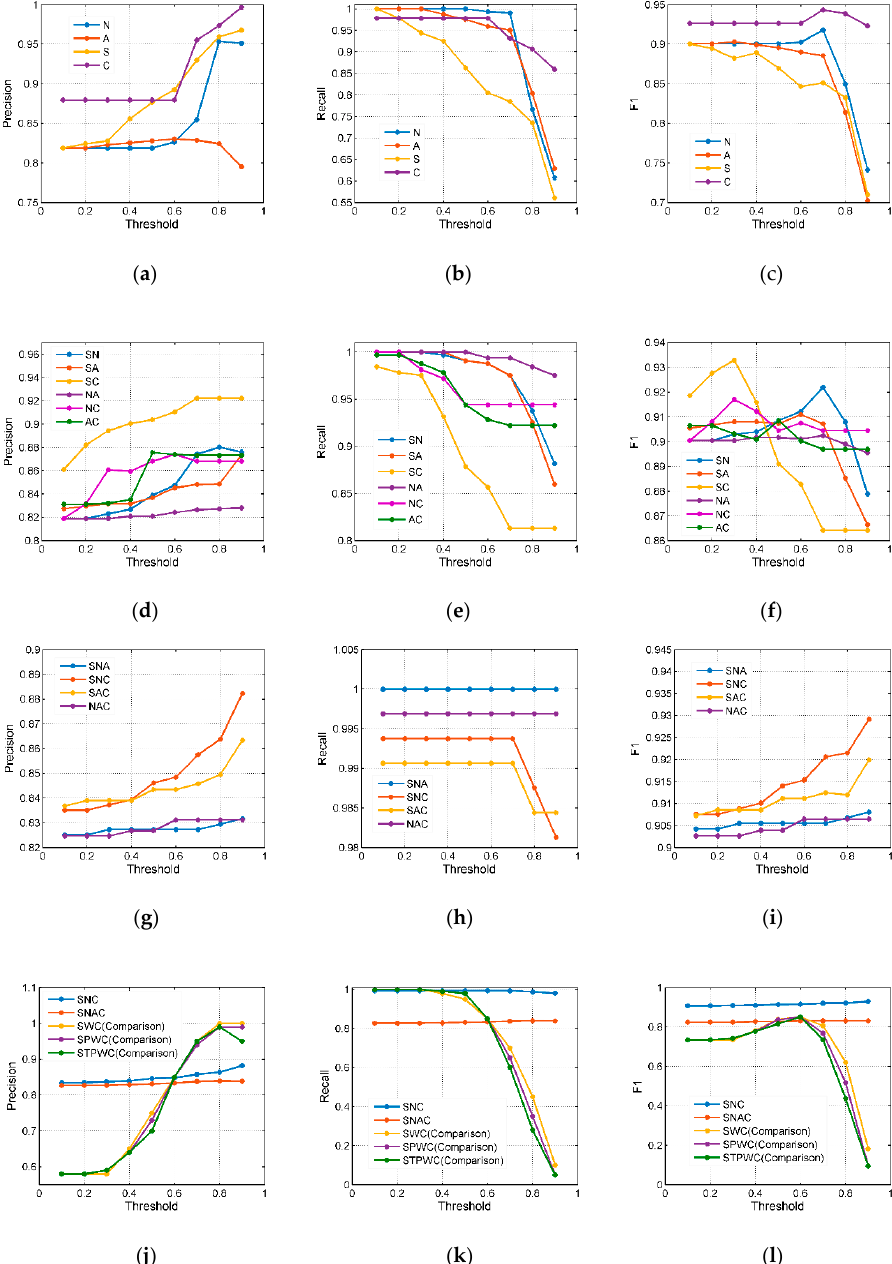
Figure 8. The precision, recall, and F1 of the one-attribute models and the two-attribute models: ( a ) The precision of the N, A, S, and C models; ( b ) the recall of the N, A, S, and C models; ( c ) the F1 of the N, A, S, and C models; ( d ) the precision of the SN, SA, SC, NA, NC, and AC models; ( e ) the recall of the SN, SA, SC, NA, NC, and AC models; ( f ) the F1 of the SN, SA, SC, NA, NC, and AC models; ( g ) the precision of the SNA, SNC, SAC, and NAC models; ( h ) the recall of the SNA, SNC, SAC, and NAC models; ( i ) the F1 of the SNA, SNC, SAC, and NAC models; ( j ) the precision of the SNC, SNAC, SWC (comparison), SPWC (comparison), and STPWC (comparison) models; ( k ) the recall of the SNC, SNAC, SWC (comparison), SPWC (comparison), and STPWC (comparison) models; and ( l ) the F1 of the SNC, SNAC, SWC (comparison), SPWC (comparison), and STPWC (comparison) models.